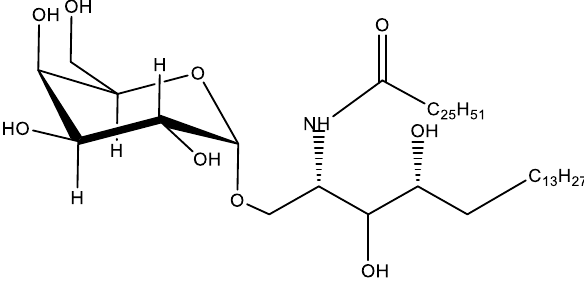
Figure 8. Structure of α